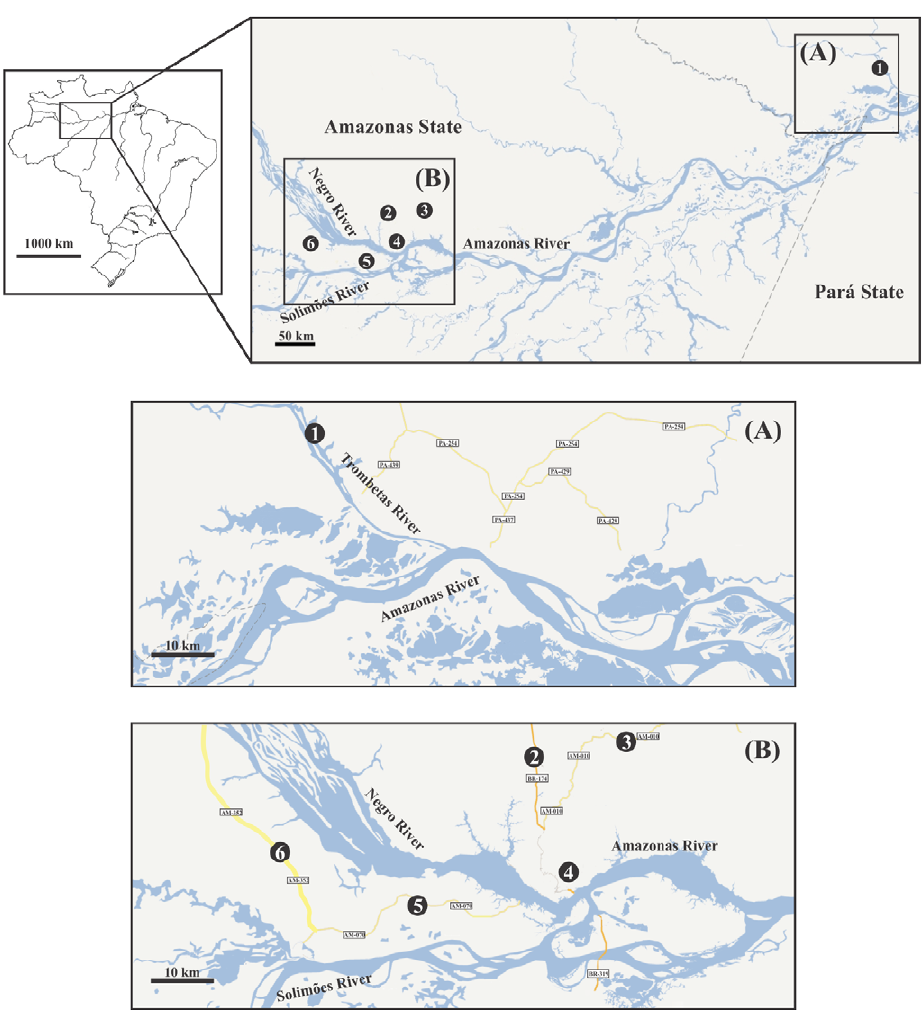
Figure 1. Collection sites of Lutzomyiaumbratilis from Amazonian Brazil. 1, Cachoeira Porteira; 2, BR-174 Highway; 3, Rio Preto da Eva; 4, Manaus; 5, Manacapuru; 6, Novo Aira˜o. Figures A and B are expanded sizes.